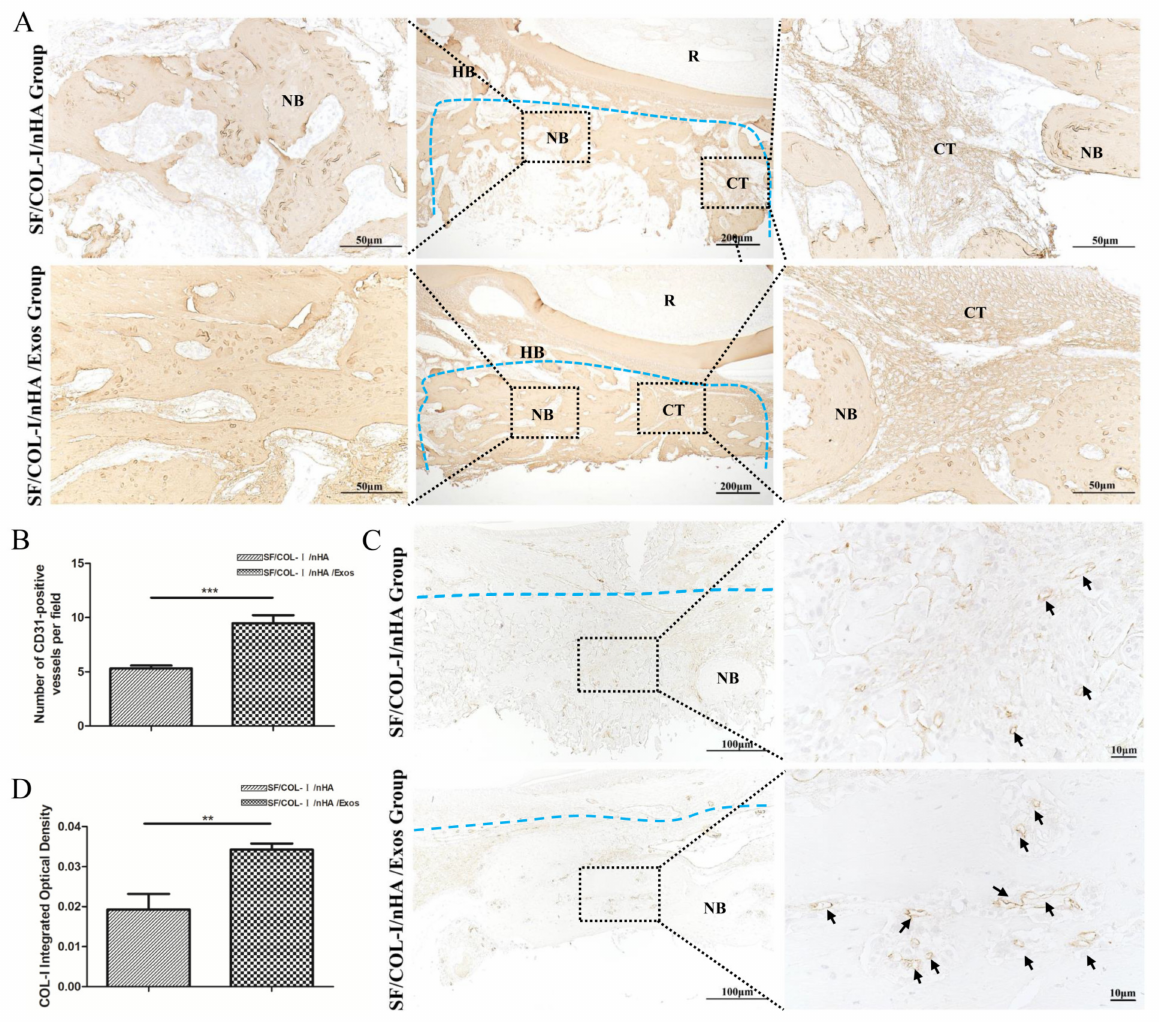
Figure 5. Immunohistochemical staining for bone regeneration and angiogenesis at 6 weeks. ( A ) COL1 staining. ( B ) Quantitative analysis of COL1 expression. ( C ) CD31 staining. ( D ) Quantita- tive analysis of CD31 expression. Brown color indicates positive expression, and the darker brown, the stronger the expression. The blue dotted line means the dividing line between new bone and host bone. Black arrows indicate blood vessels in the new bone. NB: new bone; HB: host bone; CT: connective tissue; R: root. ** p < 0.01, *** p <